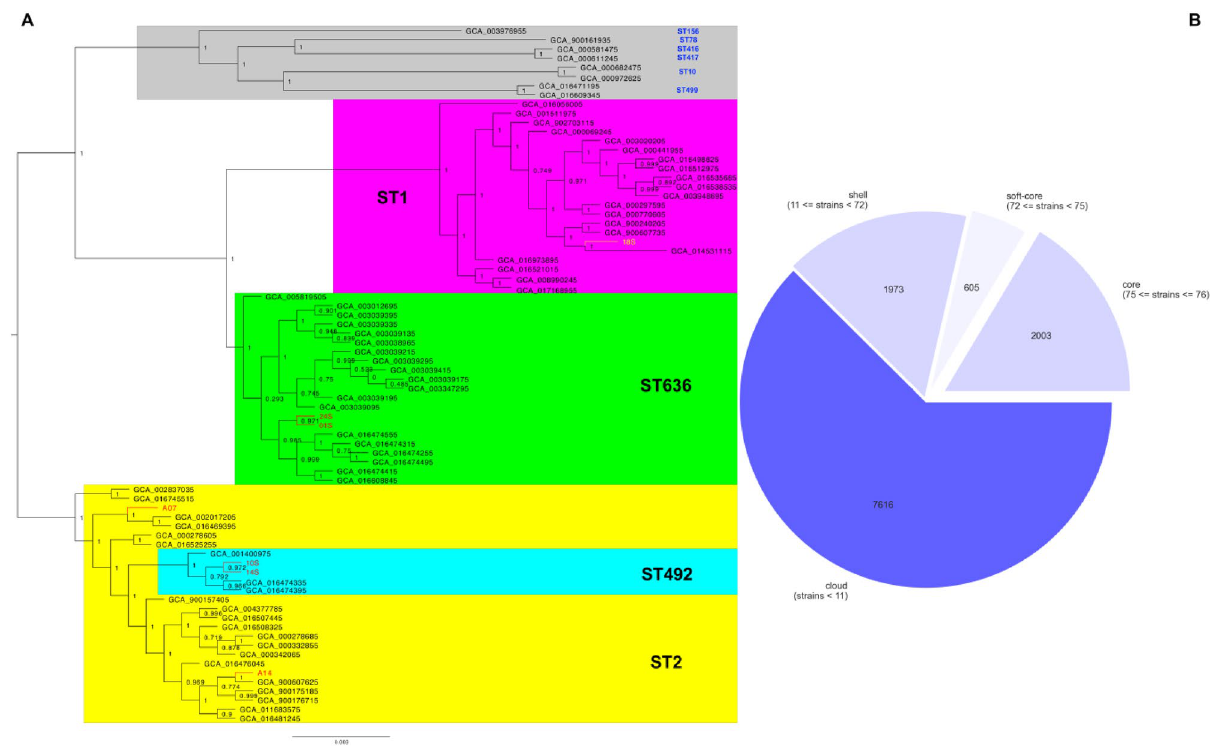
Figure 1. Phylogenetic tree of 76 genomes based on pangenome analysis. ( A ) Phylogenetic clustering; ( B ) The distribution of core and accessory genes in all 76